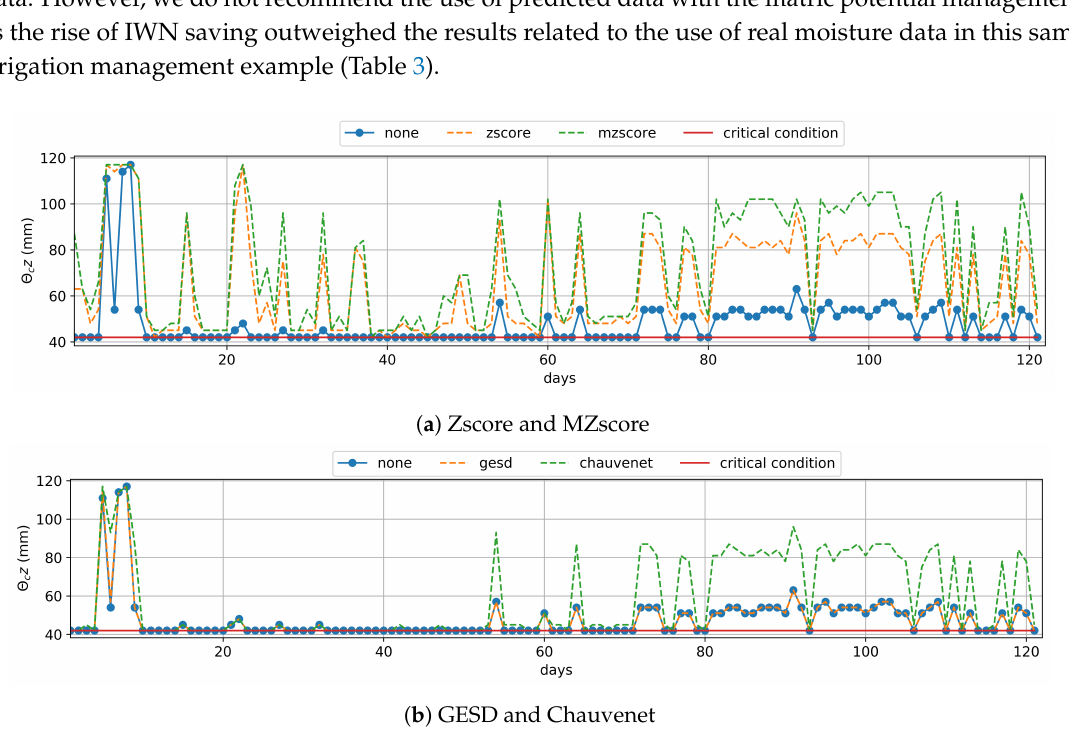
Figure 9. Predicted Moisture Data used in Matric Potential — the points outside of the dashed lines are current soil moisture θ c data modified by an outlier removal technique. Irrigation occurs when θ c is minor or equal to the critical moisture condition θ cr (red